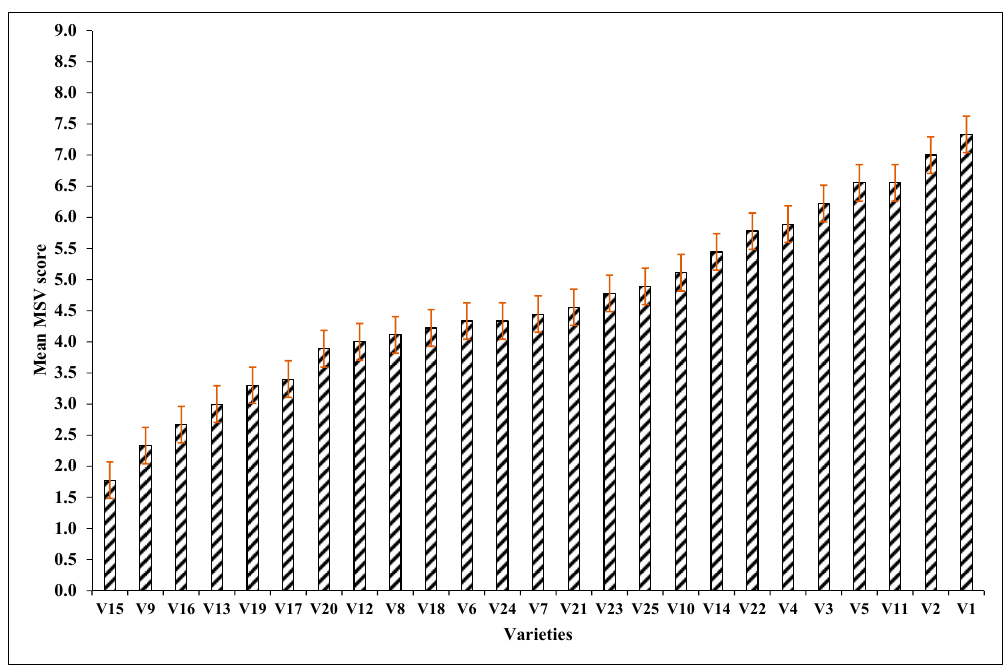
Figure 5. Mean disease response of the 25 varieties evaluated. The disease was rated on a score of 1–9, where a mean score of 1–3.4 (resistant), 3.5–5.4 (moderately resistant), and 5.5–9 (susceptible). (V1 to V25 = varieties 1 to 25.).